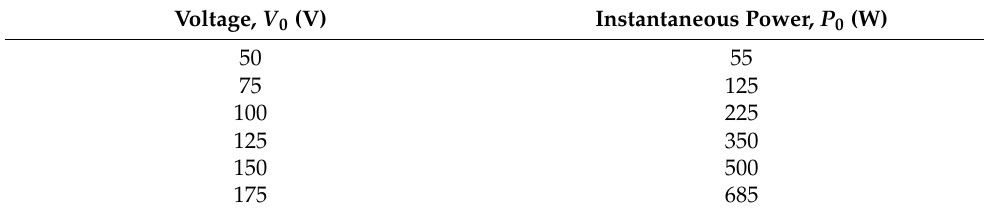
Table 2. Calculated instantaneous power values using Equation